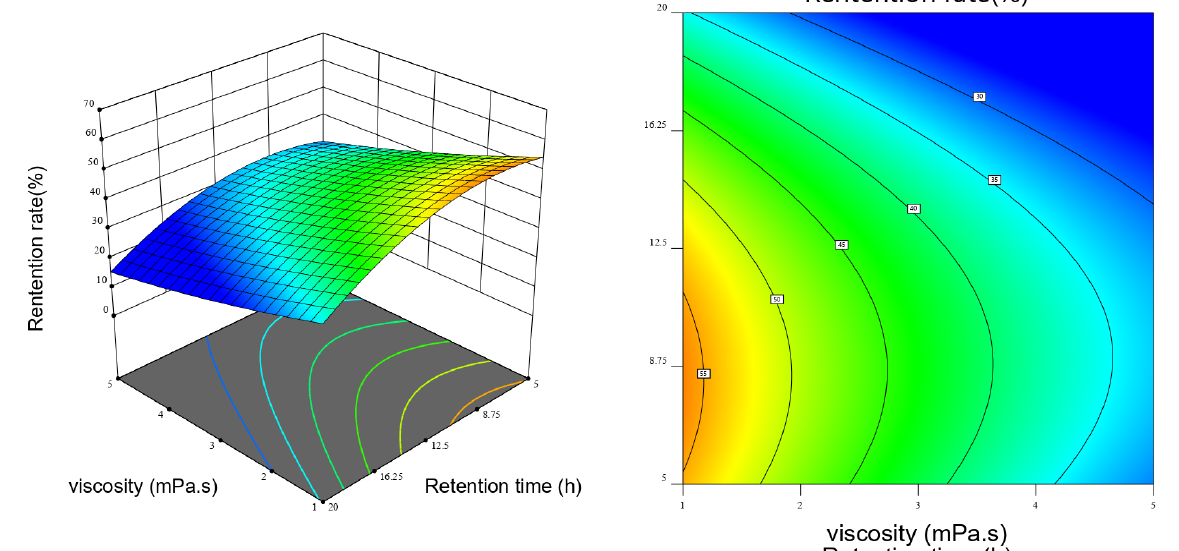
Figure 8. Response surface and contour plots (viscosity vs. retention